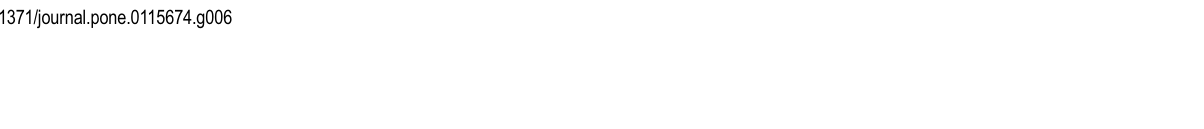
Fig 6. Scalograms (absolute values) for the periods between 8 and 128 weeks (2003 – 2009). (A) Total influenza cases. (B) Total RSV cases. Horizontal axis, weeks numbered consecutively starting 2003; vertical axis, periods in